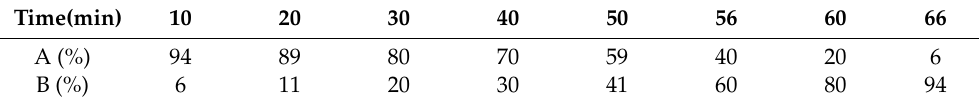
Table 1. Gradient system for the analysis of polyphenols in ethyl acetate fraction of Tradescantia pallida .